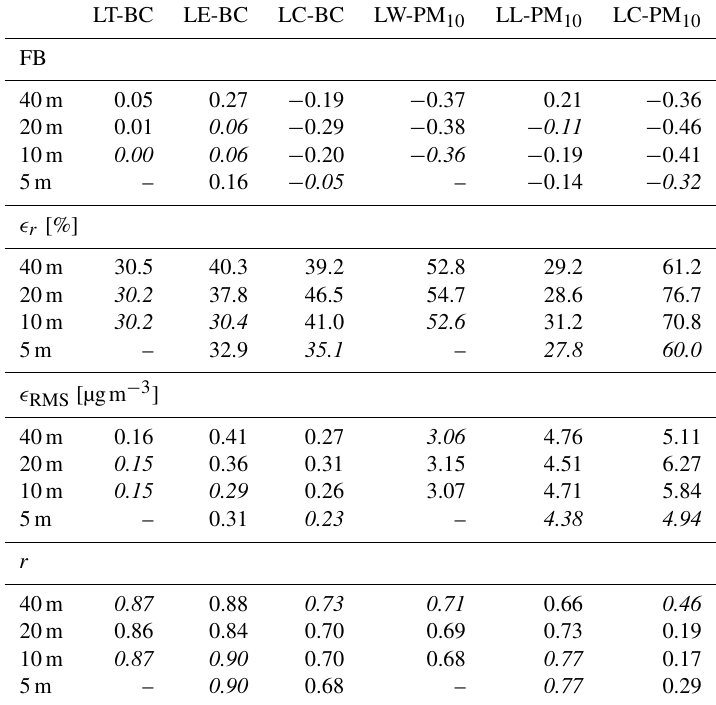
Table 3. List of model to measurement FB, model error (cid:15) , and Pearson correlation coefficient r computed for all concentration time series of the performed sensitivity runs. The best-performing model resolution for each station and criterion, respectively, is highlighted in italics. LT-BC LE-BC LC-BC LW-PM